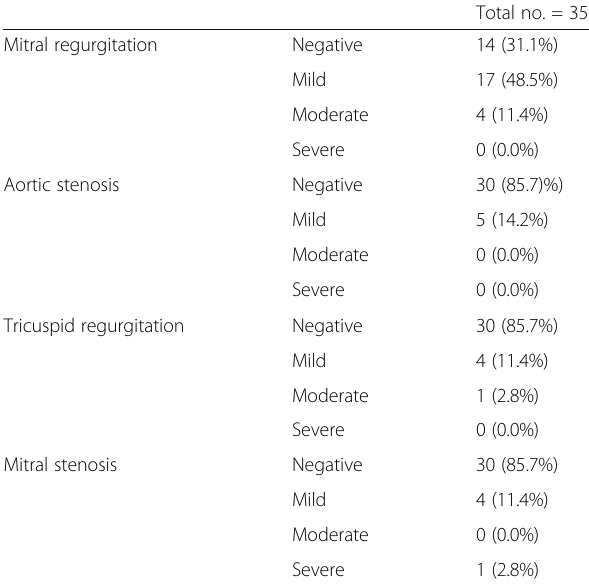
Table 2 Echocardiographic data of valvular lesions in the patient group